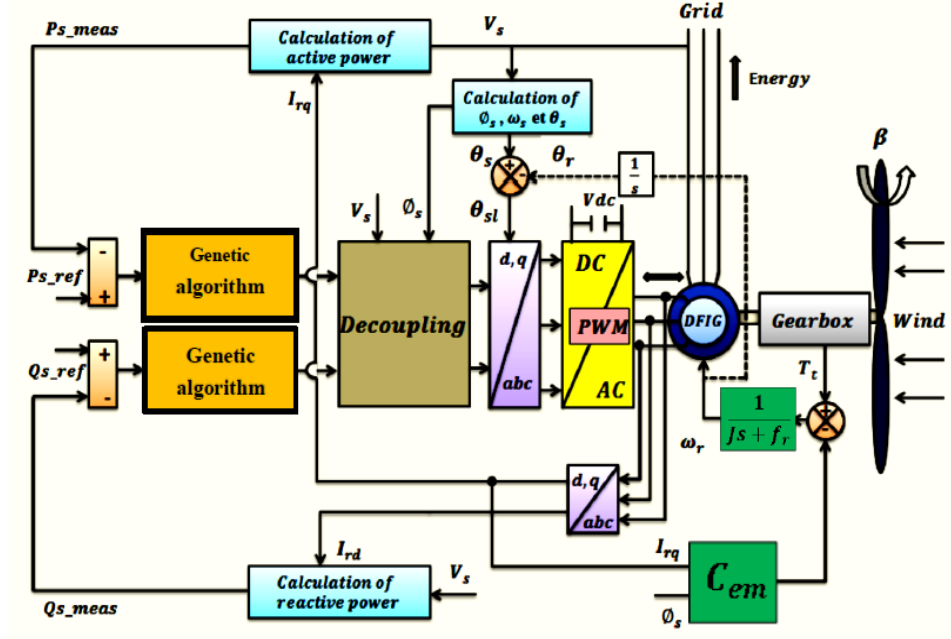
Figure 13. Global block diagram of the command of the genetic algorithm based on the doubly fed induction generator.